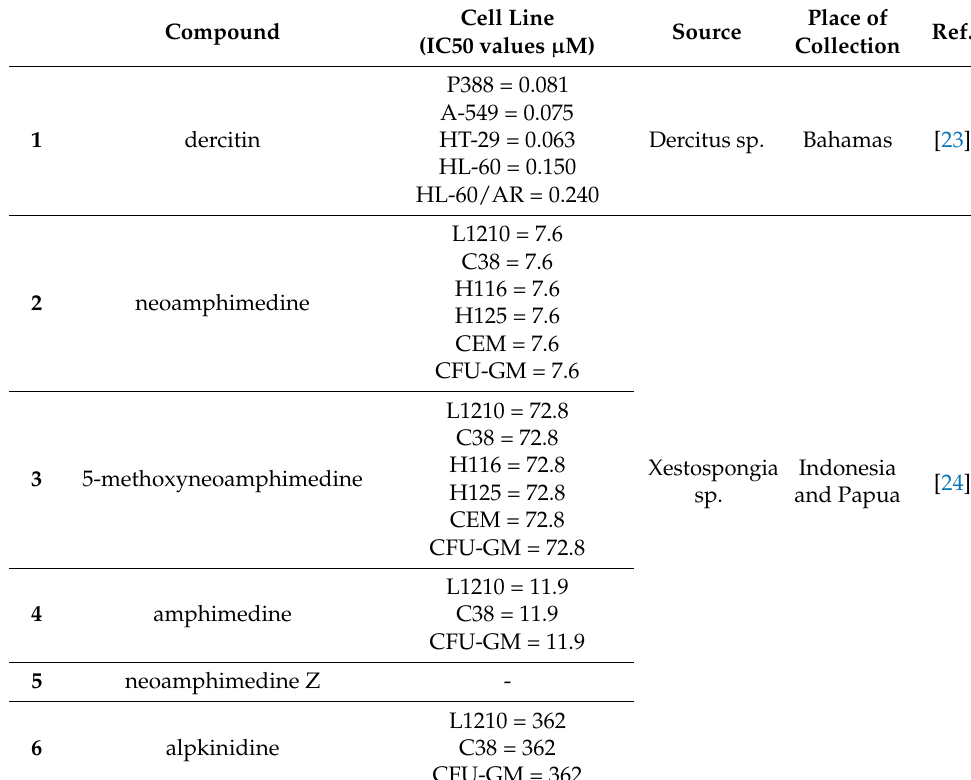
Figure 1. Structures of acridine alkaloids isolated from sponges. Table 1. Cytotoxic activity of acridine alkaloids.